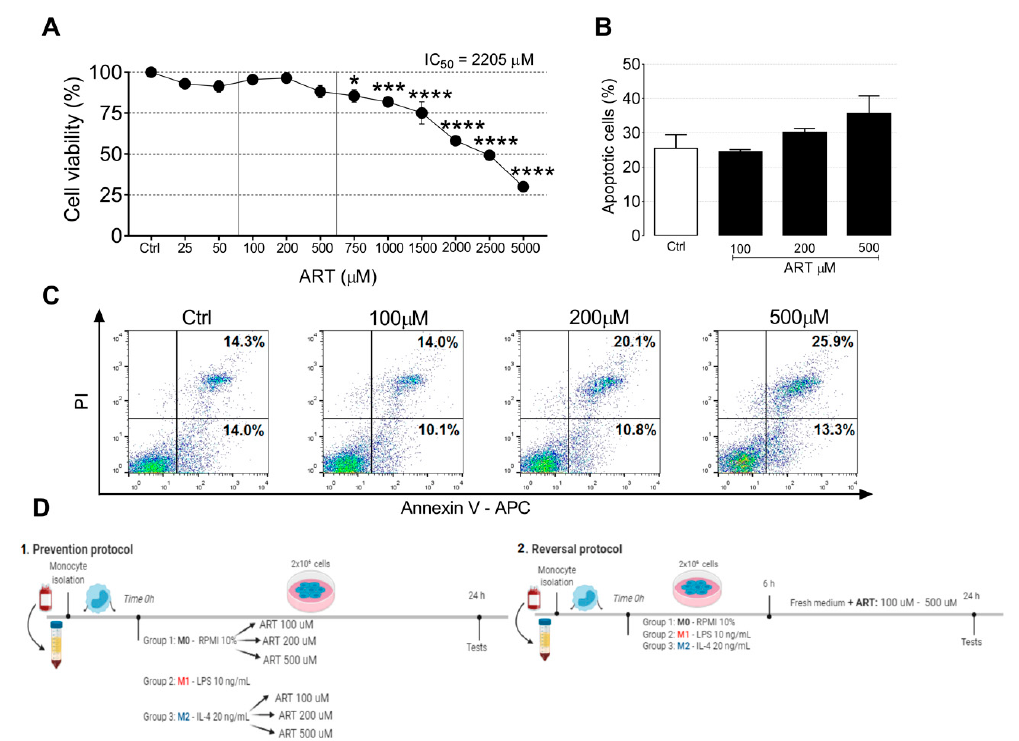
Figure 1. ART effects on human primary monocytes cell viability. Cell viability of monocytes treated with increasing doses of artesunate (ART) (25–5000 µ M) for 24 h measured by MTT assay ( A ). Cell viability of cells treated with DMSO (vehicle) were considered 100%. *, *** and, **** indicate significant difference from the control group as determined by ANOVA followed by Tukey post hoc ( p < 0.05, 0.001, and <0.0001, respectively). Monocytes were treated with 100, 200, and 500 µ M of ART for 24 h. After treatment, the cells were stained with Annexin V/PI ( B,C ). Experimental design of the two protocols used in the study ( D ). Monocytes were obtained from buffy coats of healthy blood donors. In the prevention protocol, cells were treated with LPS for M1-like monocytes or IL-4 for M2-like monocytes and ART were added at the same time. In the reversal protocol, cells were treated with LPS and IL-4 for 6 h and then ART was added in fresh medium for an additional 18 h. Cells were then collected for the next experiments.